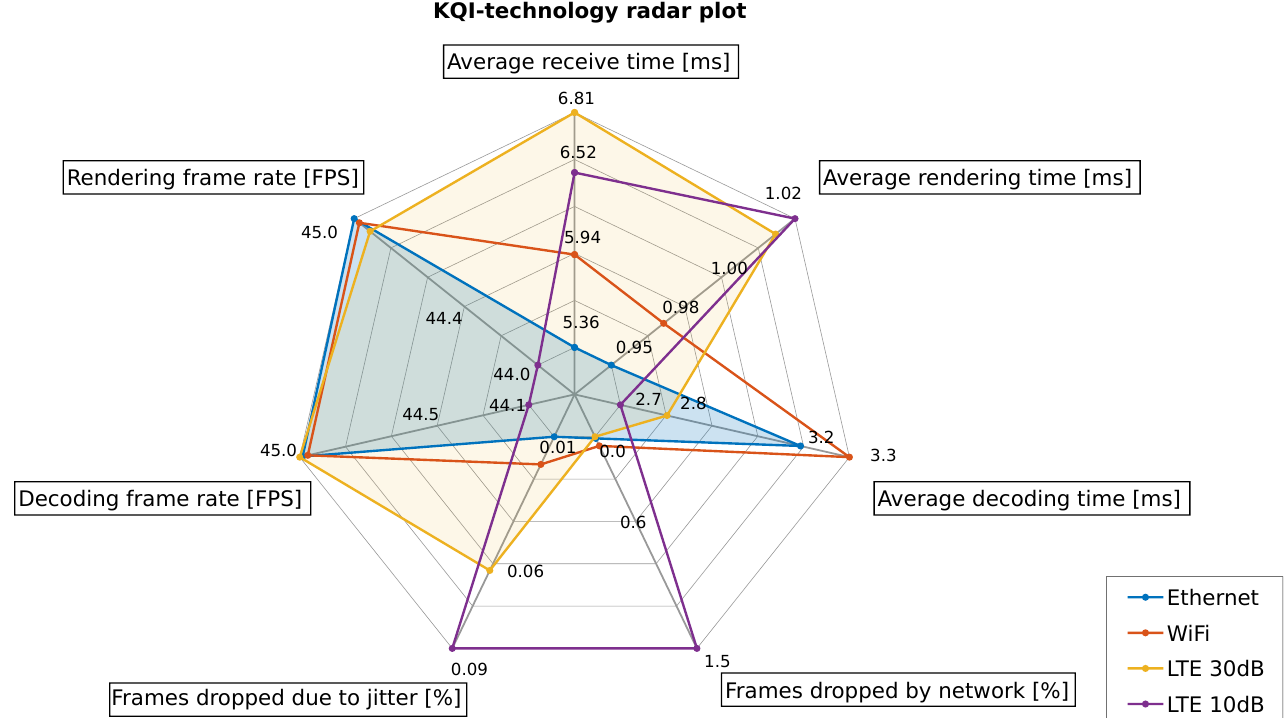
KQI-technology radar plot